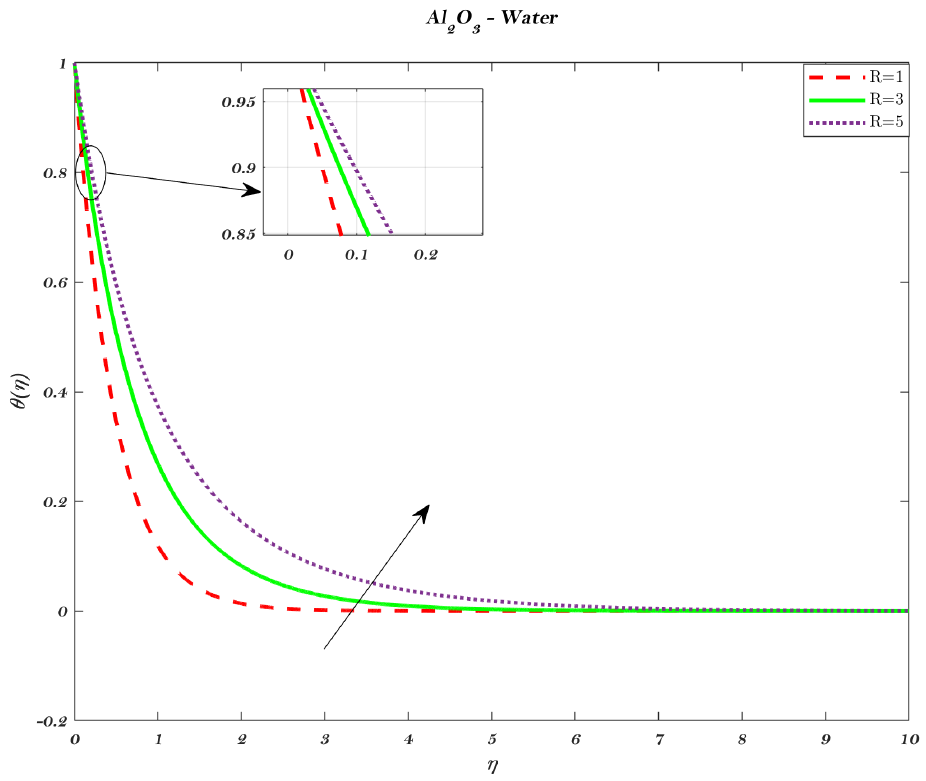
Figure 18. The radiative heat flux R against η with fix parameters ϕ = 2%, ˘ a = 0.02 and P r =